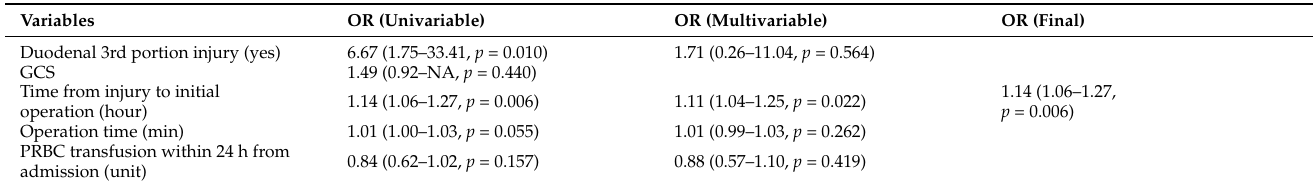
Table 2. Backward stepwise multivariable logistic regression model for postoperative leakage.